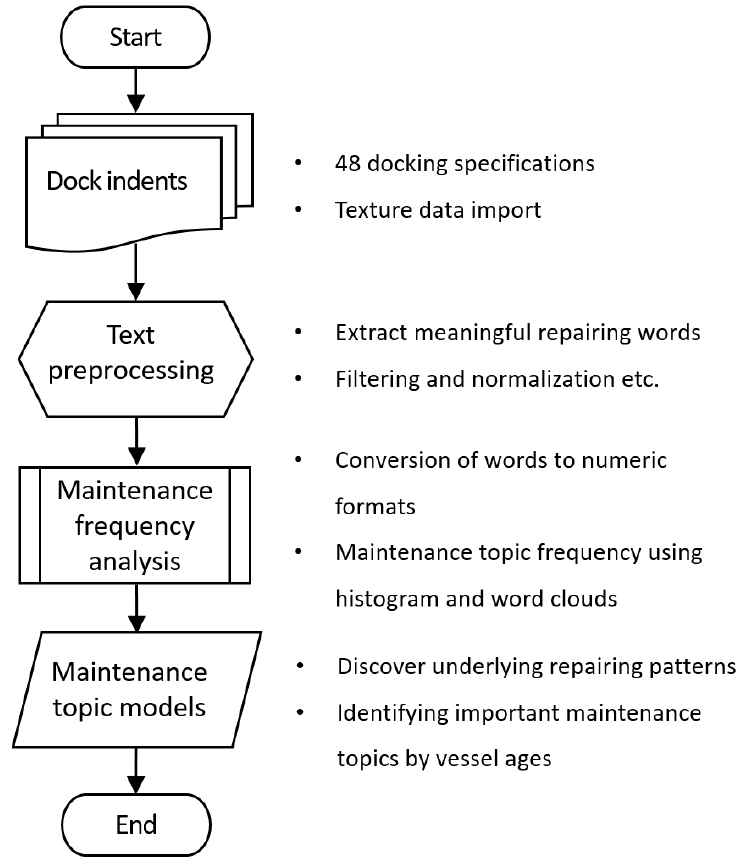
Figure 2. Framework for the development of LNG containment system maintenance topic models.